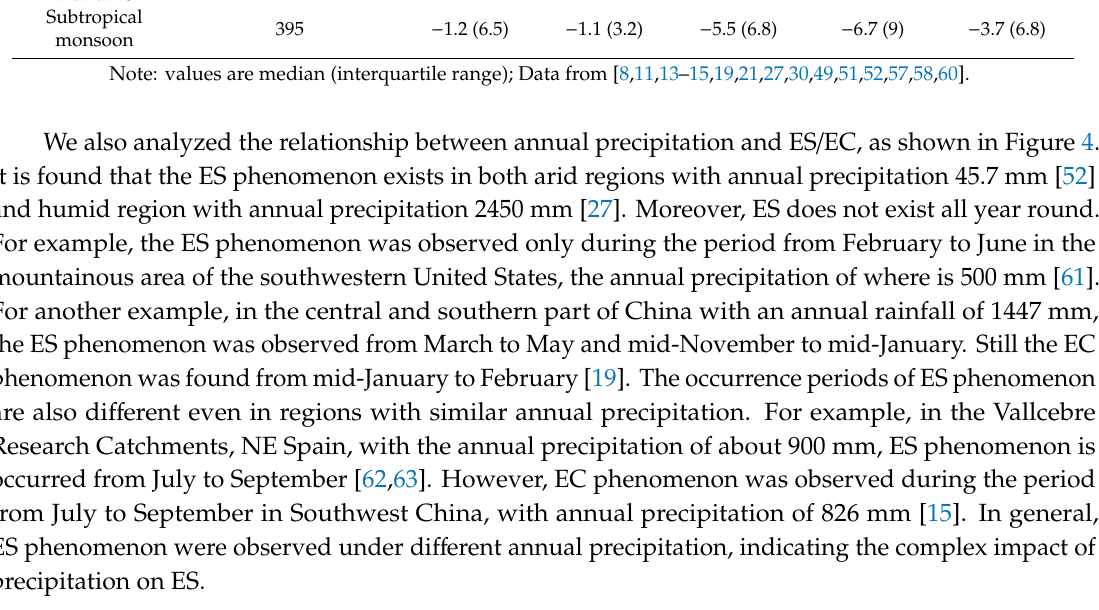
Table 1. Line-conditioned excess (lc-excess) values of di ff erent water bodies in various climate regions. Climate Number of Samples Precipitation Groundwater Stream Xylem Soil Mediterranean 537 0.2 (3.3) 1.5 (-) 0.2 (4.1) − 10.7 (6.5) Plateau 726 mountain Savanna 509 Tropical 364 rainforest Temperate 766 continental Temperate maritime